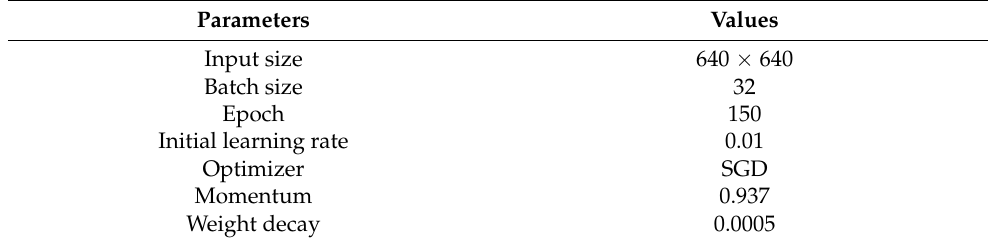
Table 2. Model training